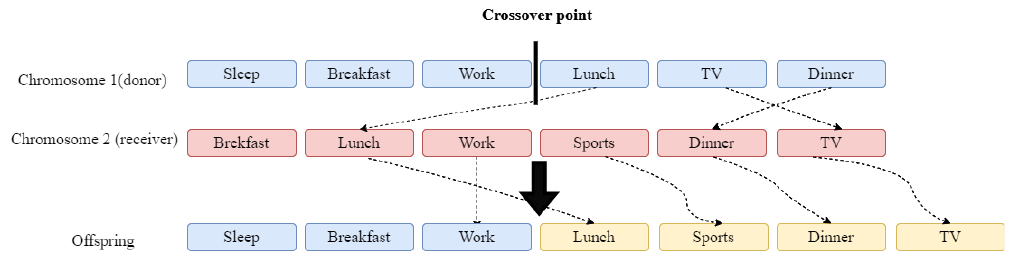
Figure 5. Maximal preservation crossover operator when the two parents do not have the same genes (blue — genes from the donor, red — genes from the receiver, orange — genes from the donor reordered as in receiver together with genes from receptor that are not in donor).